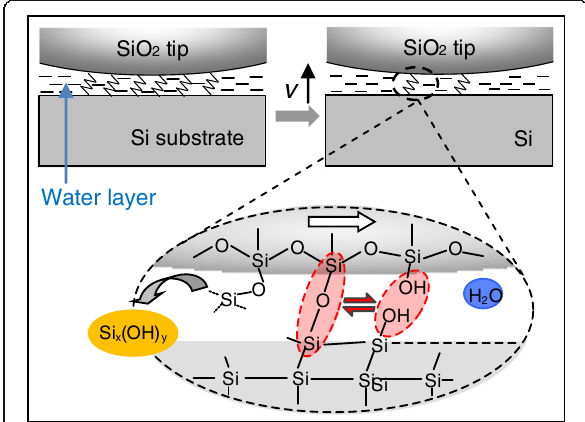
Fig. 6 Schematic showing the interfacial state of Si substrate rubbed against SiO 2 tip under humid air and in DI water with increasing sliding speed